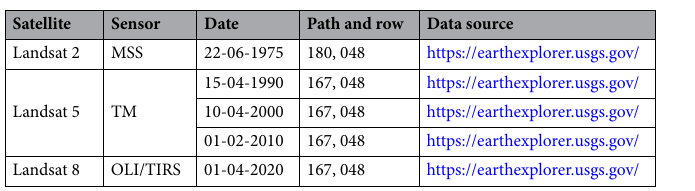
Table 1. Satellite image used for the studied